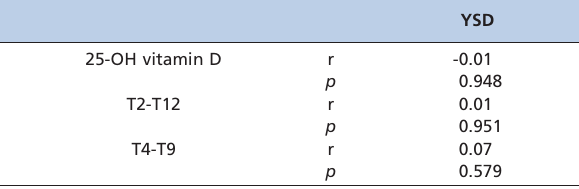
Table 3 - Correlation of thoracic kyphosis and 25-OH vitamin D with anteroposterior COP